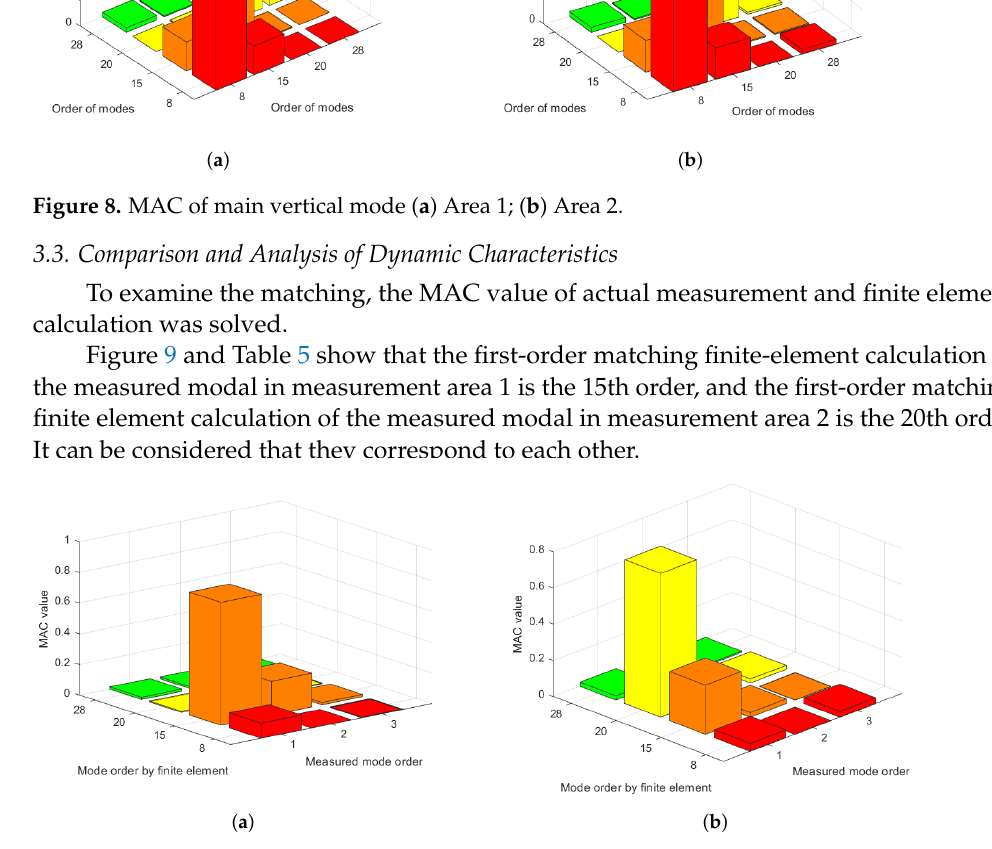
Figure 9. MAC histogram of measured mode and finite-element calculation mode. ( a ) Area 1; ( b ) Area